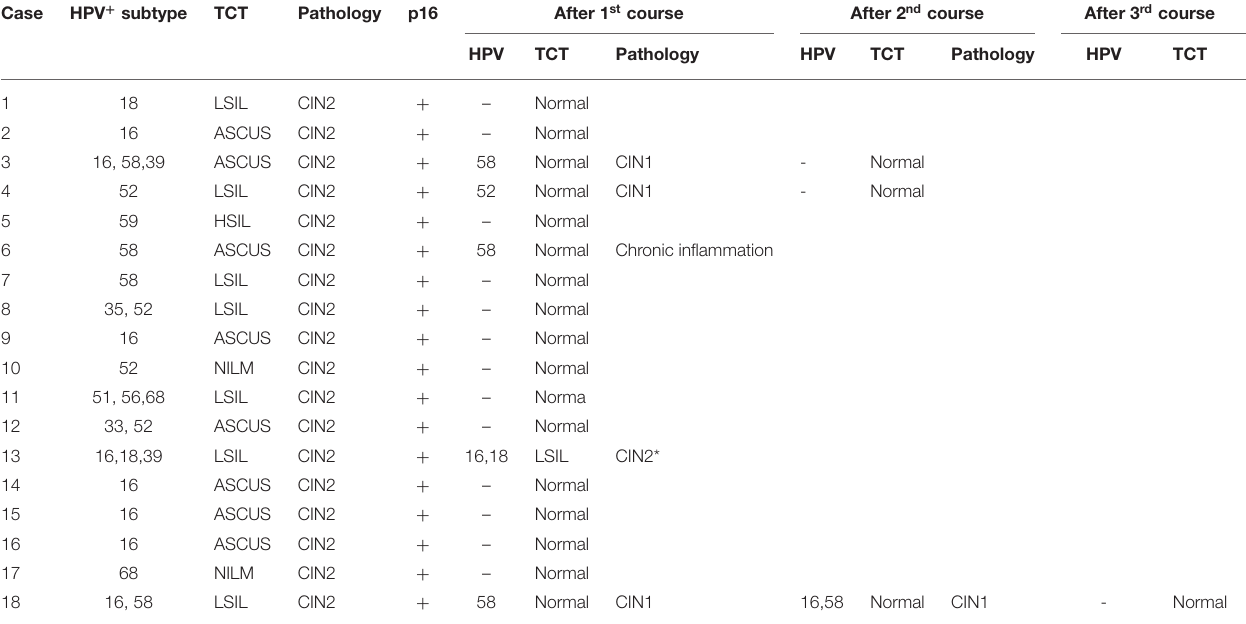
TABLE 1 | REBACIN ® effect on the regression of hrHPV-associated CIN2.